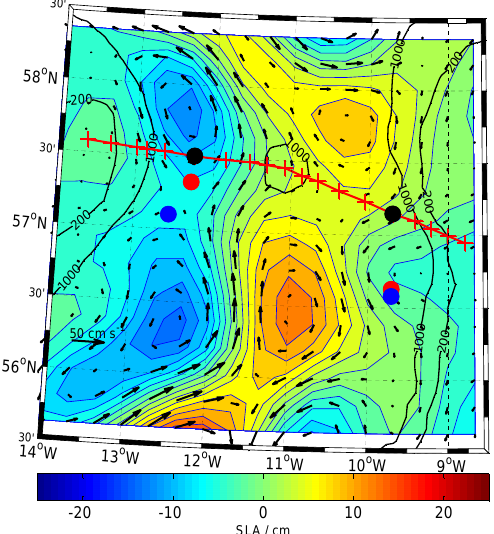
Figure 8. SLA and associated surface velocities (scaled by the 50cms − 1 arrow near the bottom of the left side) on 18 June 2009. In red is the track of D340 with the positions of CTD profiles shown as “ + ”. The dots are the positions of the profiles either side of the ADS in Fig. 3 shown as black (June 2009), red (October 2009) and blue (February 2010). Isobaths are in m.